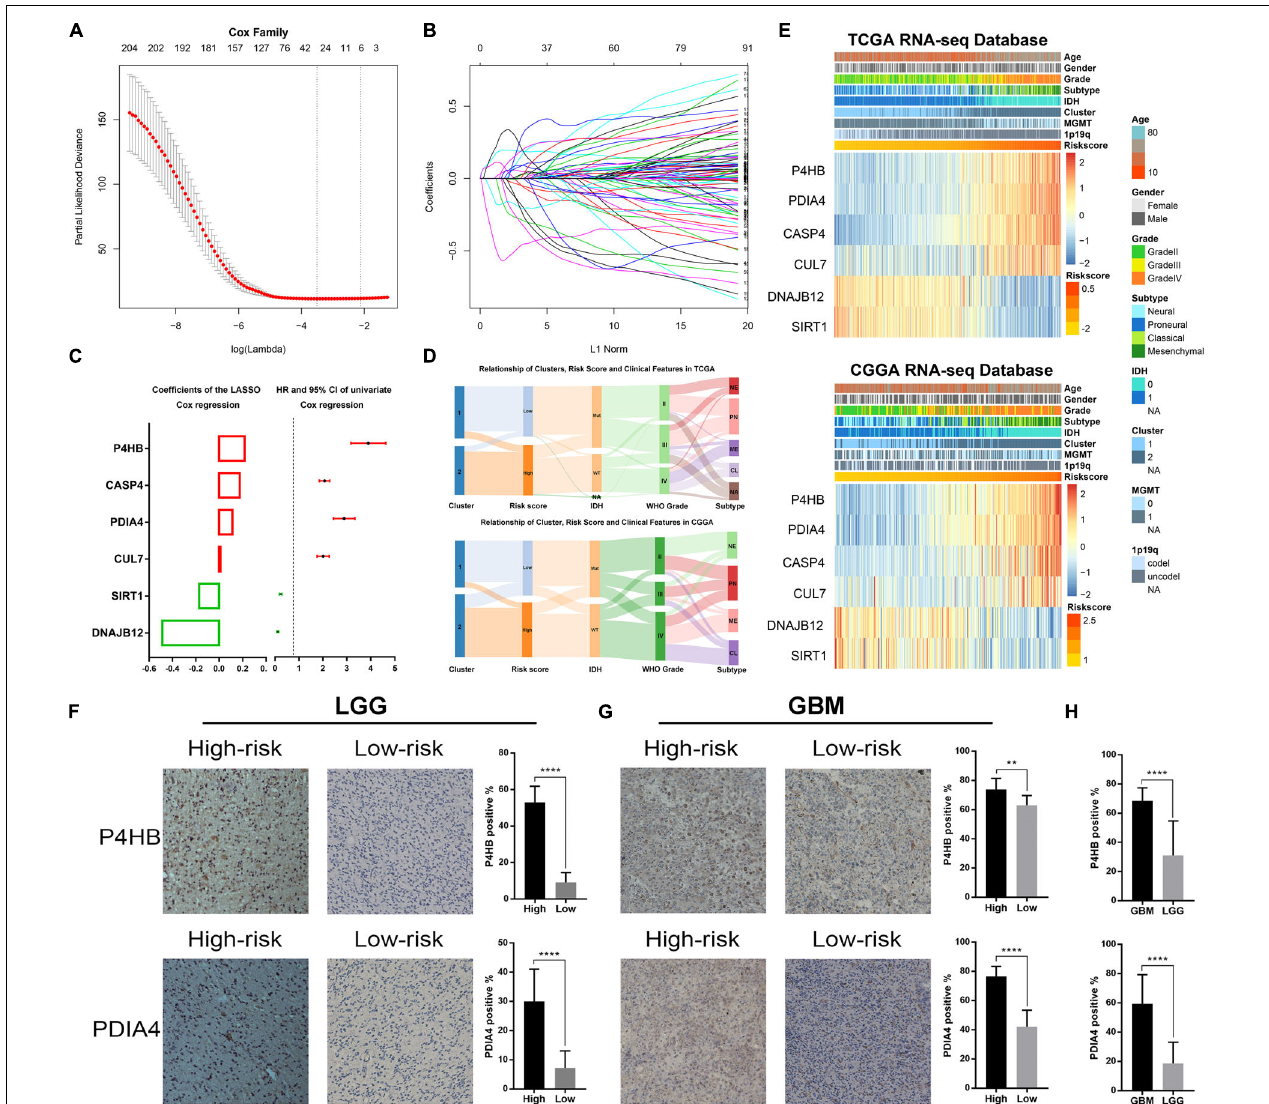
FIGURE 1 | Identification of the ER stress-related signature. (A) Cross-validation for tuning parameter screening in the LASSO regression model. (B) The coefficient profiles of the LASSO regression model. (C) The six genes’ hazard ratios (HRs) and 95% confidence intervals (CIs) by univariate Cox regression analysis (right) and the coefficients by multivariate Cox regression analysis using LASSO (left). (D) Sankey diagram exhibiting the association among cluster, risk score and clinical features of glioma samples in TCGA and CGGA datasets. (E) Heat maps of six genes in the risk signature based on the risk score in TCGA and CGGA datasets. (F) IHC staining and positive rate statistics of PDIA4 and P4HB in LGG samples from the CGGA dataset. (G) IHC staining and positive rate statistics of PDIA4 and P4HB in GBM samples from the CGGA dataset. (H) Positive rate statistics of PDIA4 and P4HB between LGG and GBM samples from the CGGA dataset. ** p < 0.01, **** p <